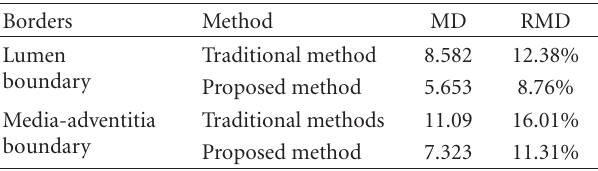
Table 1: Quantitative comparison of the results segmented from simulated images.